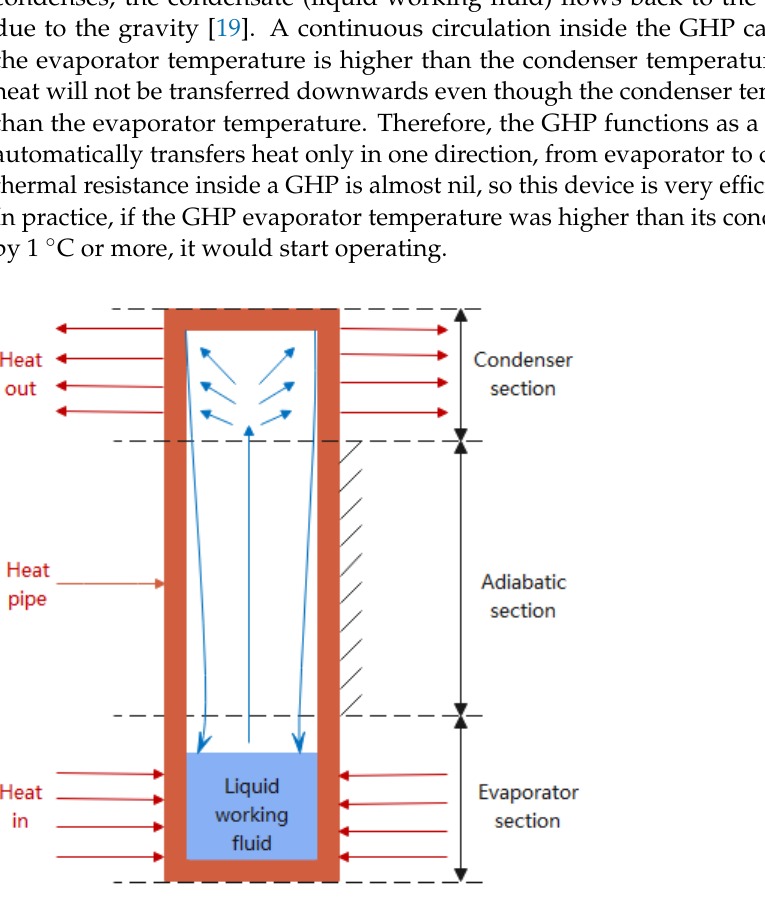
Figure 1. Gravity heat pipe working diagram.